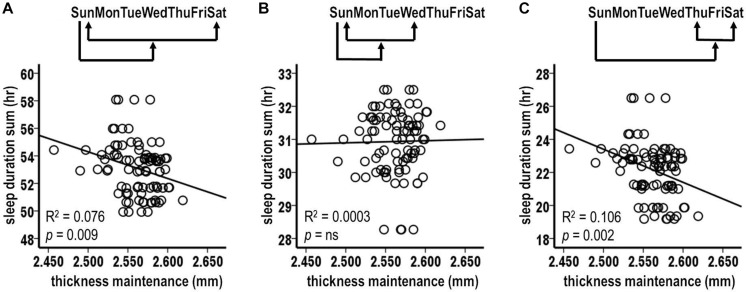
Relationships between preceding thickness maintenances and subsequent week sleep durations from tests comparing mid-day thickness maintenances on preceding Sundays vs. accumulated sleep durations over subsequent Sunday-Saturday week (A), Sunday–Wednesday early week segment (B), and Thursday-Saturday latter week segment (C) periods. Fluctuations in preceding thickness maintenance were significantly inversely related to summed sleep durations for subsequent Sunday-Saturday week (A) and Thursday-Saturday latter week segment (C) periods. Note that compared to Figures 2–4, the axes in these scatterplots and Figure 6 are inverted to reflect that sleep duration was the preceding variable in Figures 2–4, whereas here and in Figure 6 thickness maintenance is the preceding variable.